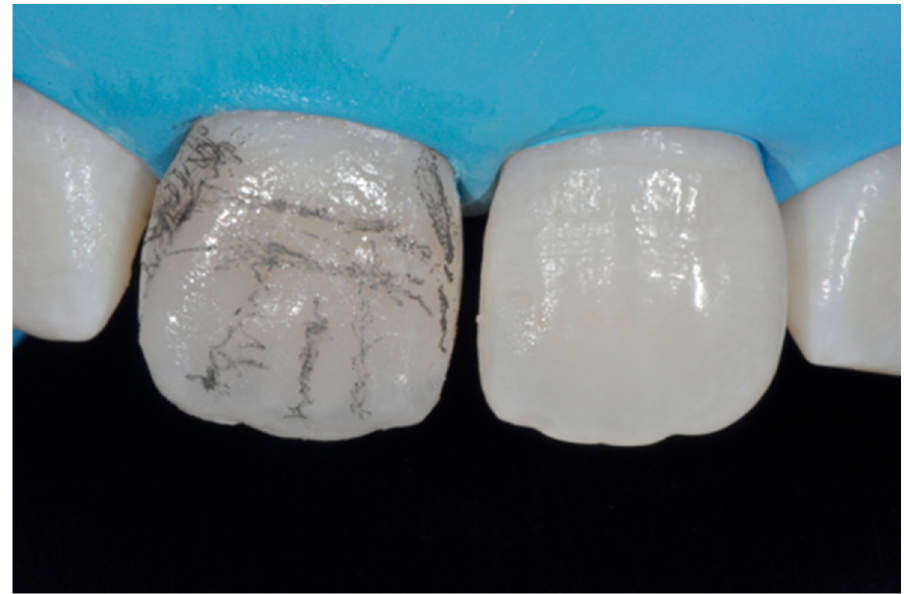
Figure 13. Vertical and horizontal anatomy outlined with a pencil. Reprinted from Restauri diretti nei settori anteriori, G. Paolone, S. Scolavino, © 2021, with permission from Quintessence Publishing Italy.